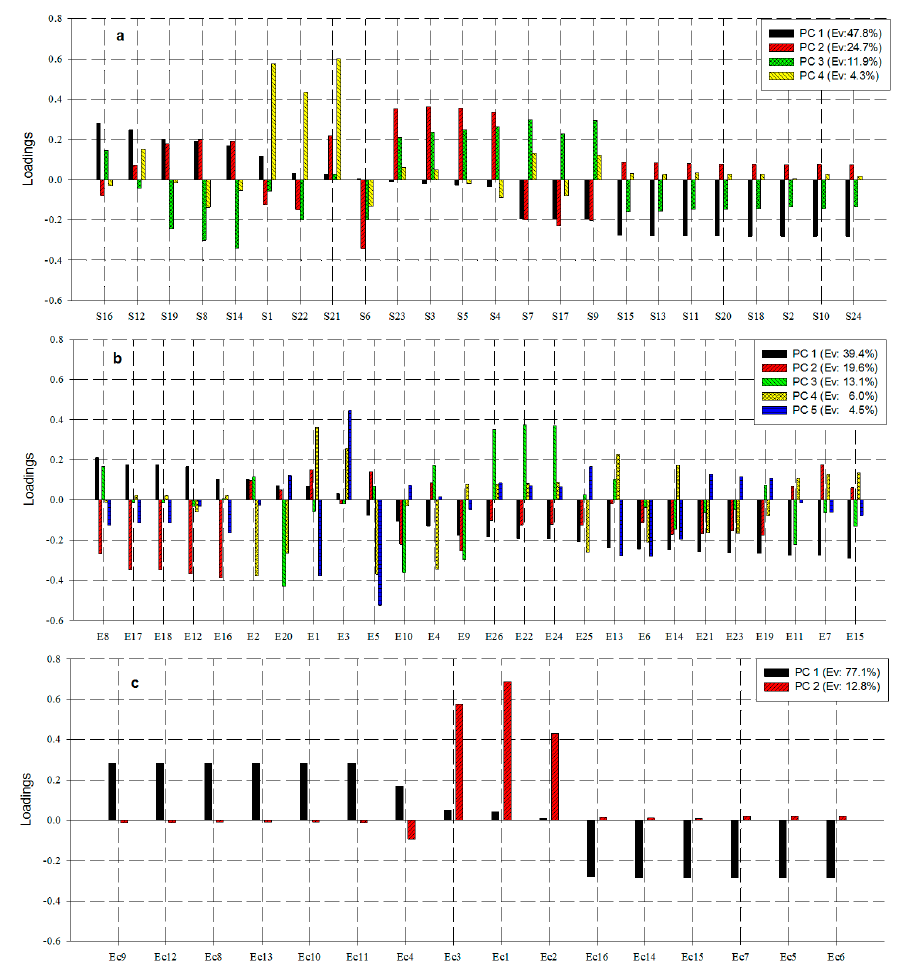
Figure 3. Principal component weights. Subsystem: ( a ) social; ( b ) environmental; ( c ) economic. Ev: explained variance.